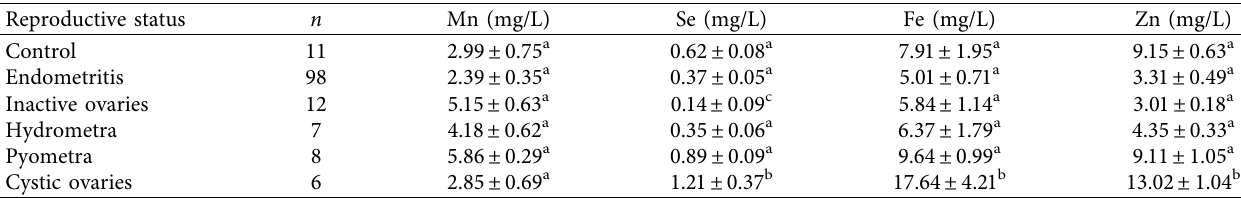
Table 1: Manganese (Mn), selenium (Se), ferrous (Fe), and zinc (Zn) serum levels in ewes with various reproductive disorders compared with control.